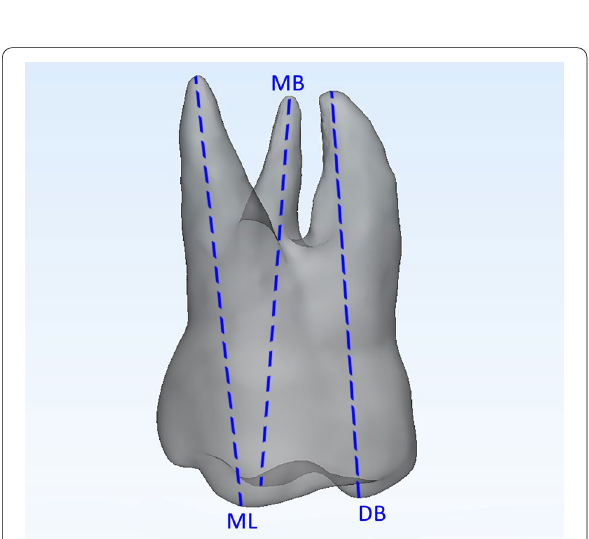
Fig. 2 Assessment of root length. Mesiobuccal root assessed as the linear distance between the tip of the mesiobuccal cusp (MB) and the apex of the mesiobuccal root; distobuccal root assessed as the linear distance between the tip of the distobuccal cusp (DB) and the apex of the distobuccal root; and palatal root assessed as the linear distance between the tip of the mesiolingual cusp (ML) and the palatal root apex